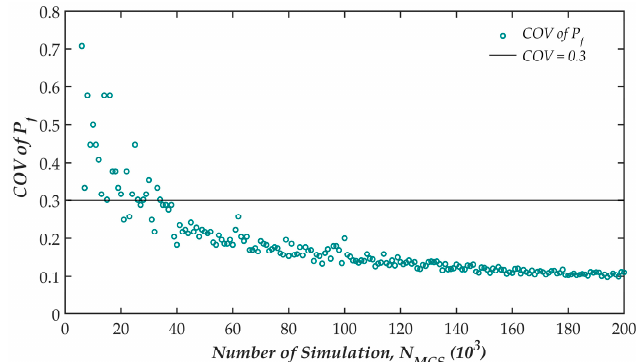
Figure 5. Convergence of the Monte Carlo simulation (MCS) for sliding failure mode, (Onsan BRW).